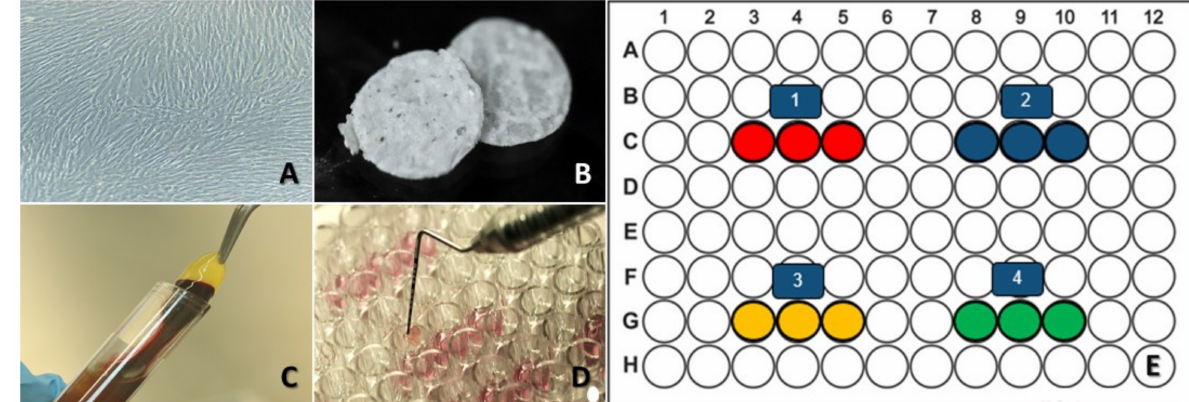
Figure 1. Experimental processes. ( A ) Human periodontal ligament fibroblasts culture; the cells show their characteristic spindle shape. ( B ) HAp-egg shell/PLGA scaffold used for all groups in the form of a 5 mm disc with 2 mm height. ( C ) Platelet-Rich Fibrin (PRF), with gelatinous consistency, a charac- teristic of this biomaterial. ( D ) Experimental design in a 96-well plate, containing the HPdLF culture medium. ( E ) Figure illustrating the four evaluated groups: red (HAp-egg shell/PLGA + HPdLF), blue (HAp-egg shell/PLGA + HPdLF + Collagen), yellow (HAp-egg shell/PLGA + HPdLF + PRF) and green (HAp-egg shell/PLGA + HPdLF + Collagen +